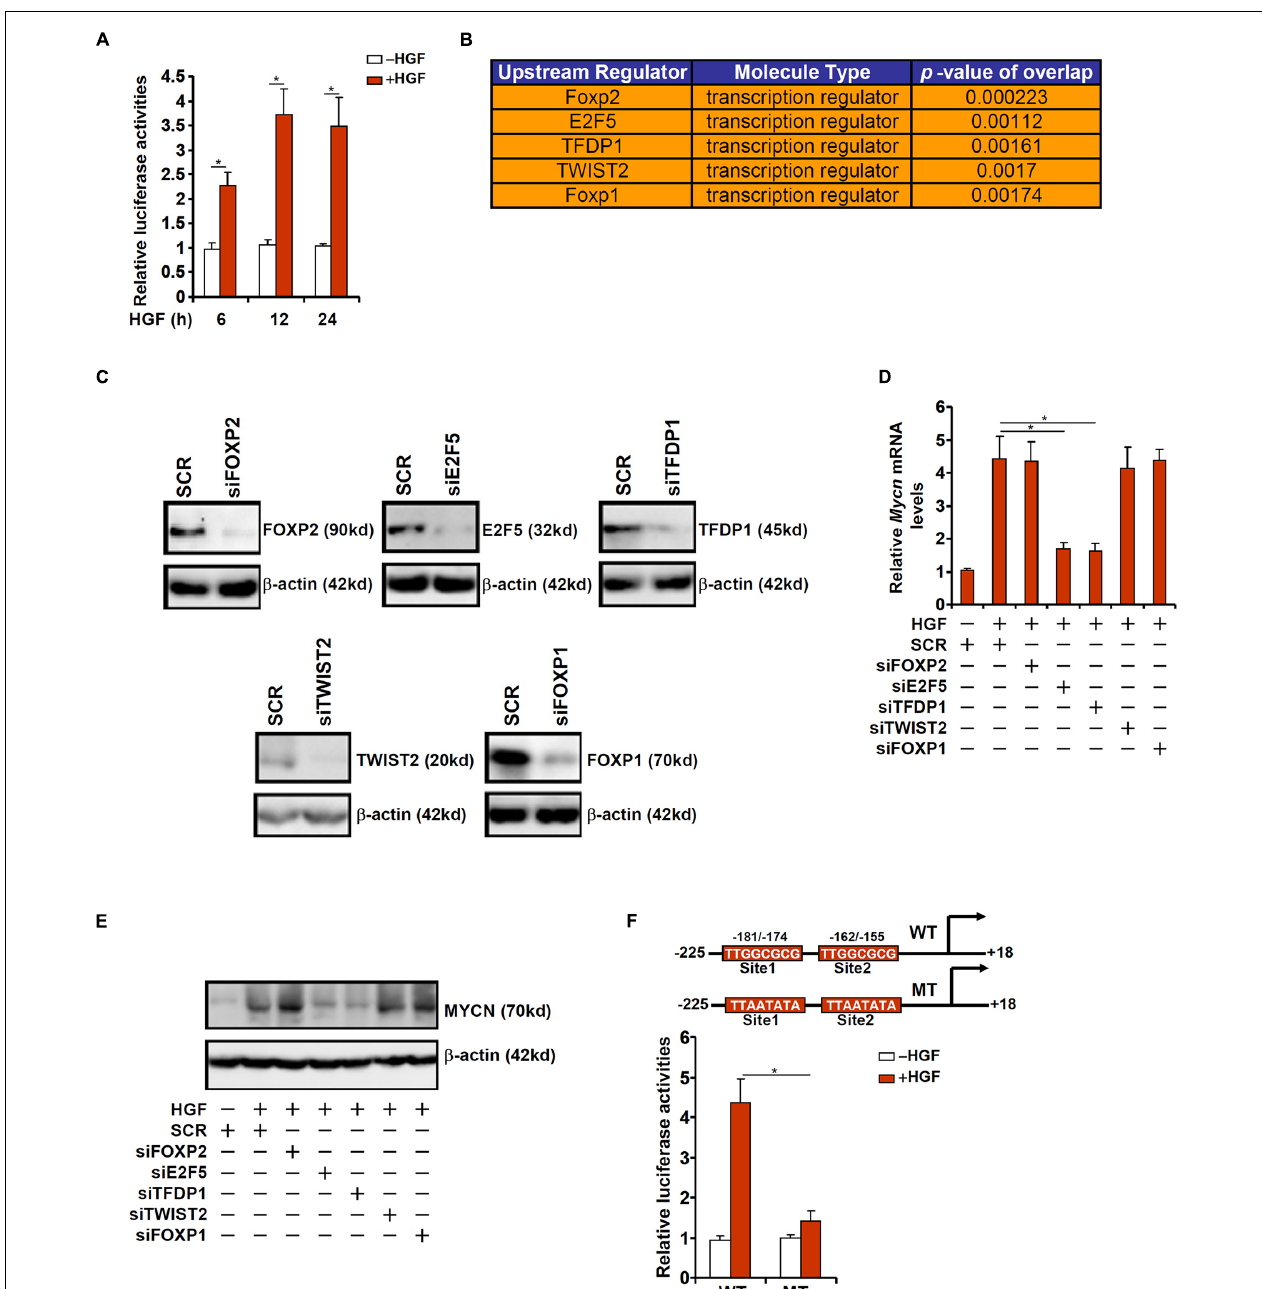
FIGURE 2 | HGF induced MYCN transcription requires an intact E2F site. (A) A MYCN promoter-luciferase construct was transfected into HepG2 cells followed by treatment with HGF. The cells were harvested at indicated time points and luciferase activities were normalized by GFP fluorescence and protein concentration. (B) IPA analysis of upstream regulators of MYCN. (C) Primary murine hepatocytes were transfected with indicated siRNAs. Knockdown efficiencies were verified by Western. (D,E) Primary murine hepatocytes were transfected with indicated siRNAs followed by treatment with HGF for 24 h. MYCN expression was examined by qPCR and Western. (F) WT or mutant MYCN promoter-luciferase construct was transfected into HepG2 cells followed by treatment with HGF for 24 h. Luciferase activities were normalized by GFP fluorescence and protein concentration. Data are expressed as mean ± standard deviation (SD). * p <0.05 (one-way ANOVA with post hoc Scheffe